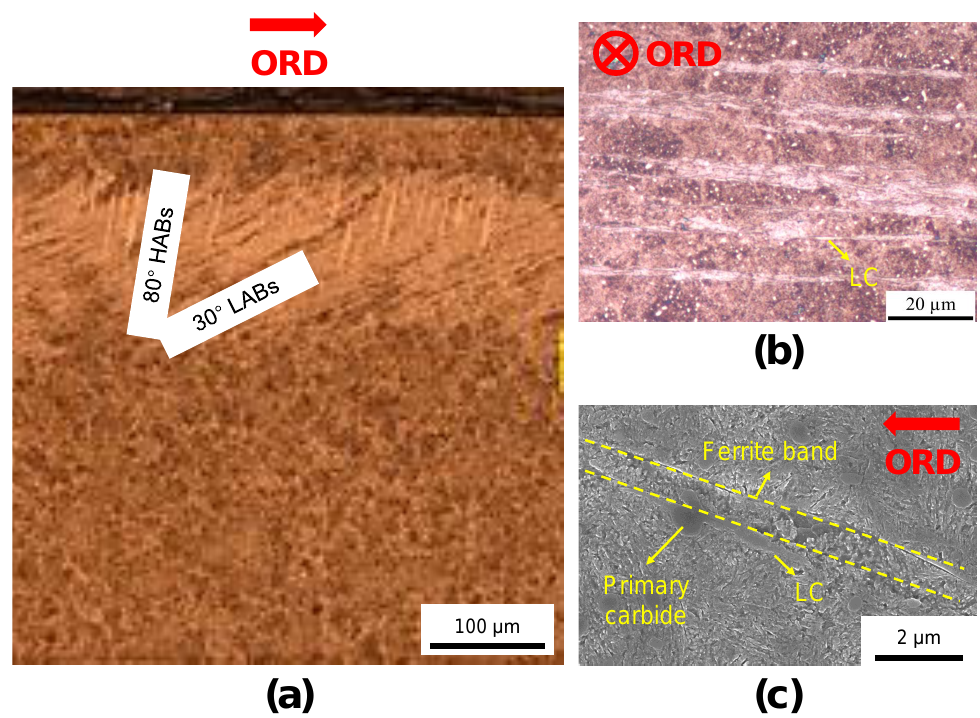
Figure 5. Formation of WEBs. ( a ) Optical image of LABs and HABs in the circumferential section (image adapted from ref. [57]). The RCF test was conducted with a contact pressure of 2.9 GPa for 3 × 10 9 cycles. ( b ) Optical image of LABs in axial section (image adapted from ref. [10]). ( c ) Unpublished SEM image